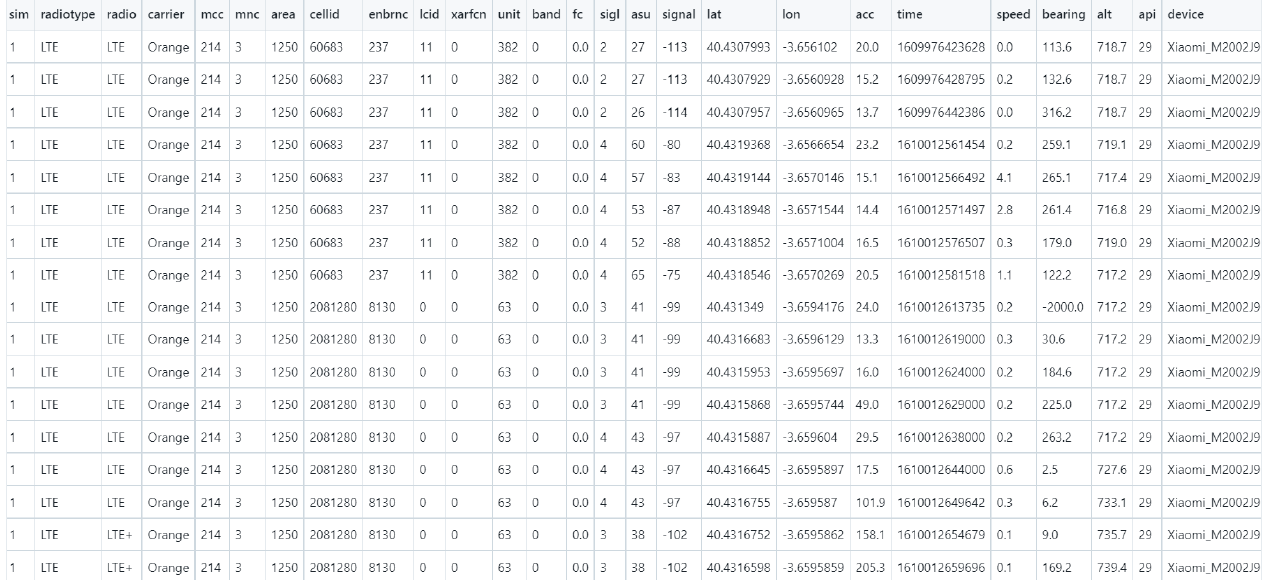
Figure 10. 4G LTE data signal collected from the UAV mission.